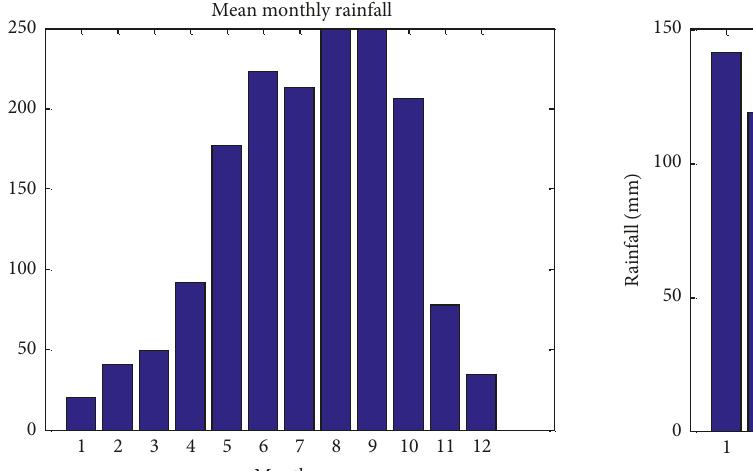
Figure 7: Histogram of the mean monthly rainfall in Singapore.